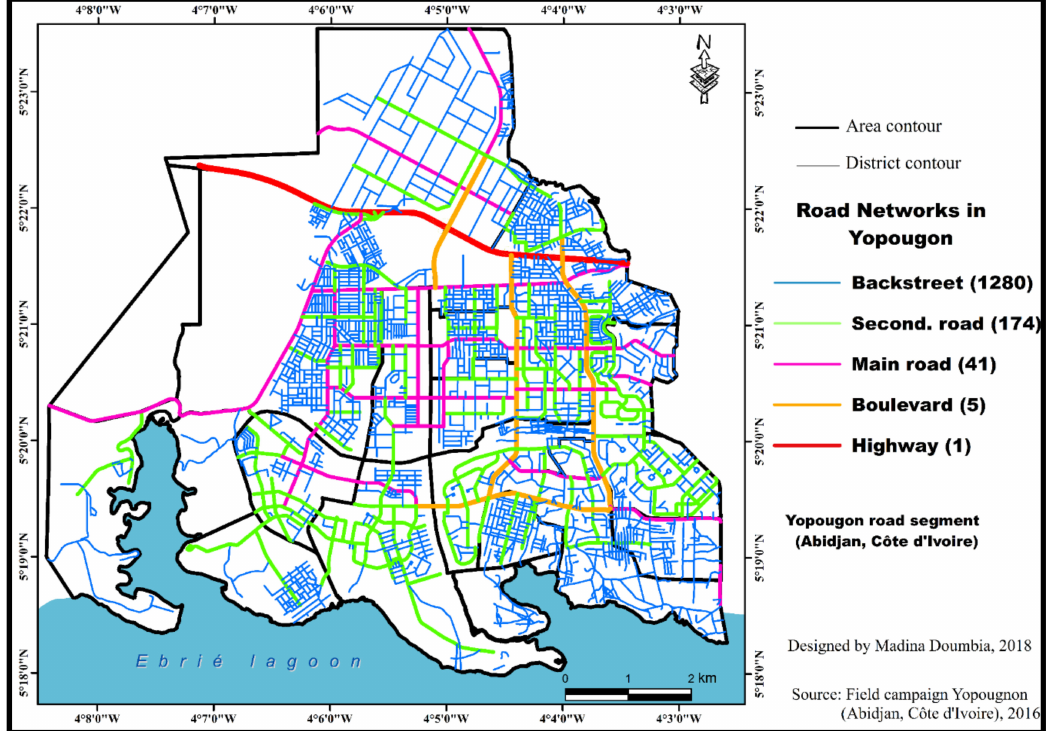
Figure 2. Yopougon network with different road segments. Number of road segments of each road type are in